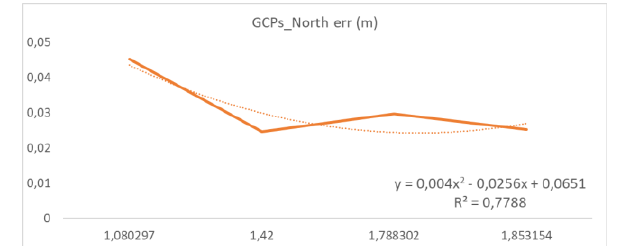
Figure 12. Predictive function extracted through a polynomial interpolation between depend (synthetic index) and independent variables (northern error component). R 2 : coefficient of determination.